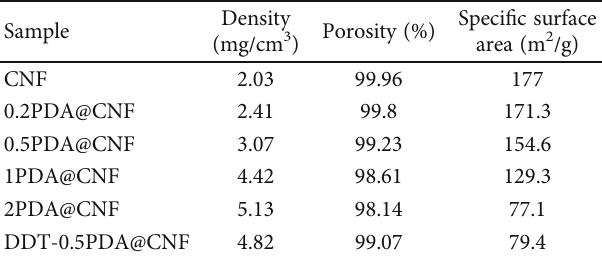
Figure 6: The graphic illustration of constructing the DDT-PDA@CNF composite interface. Table 2: Bulk densities and porosities and speci fi c surface areas of CNF and composite